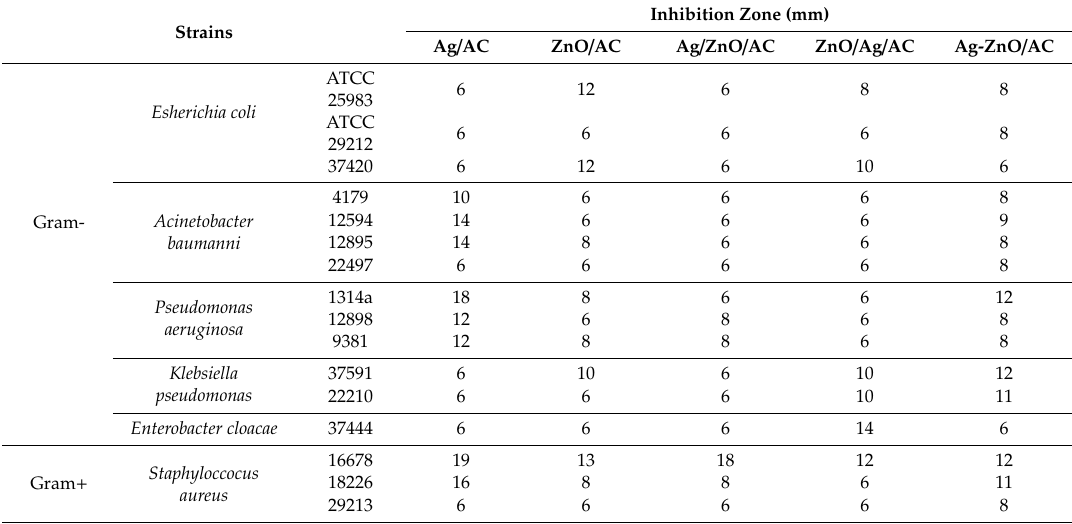
Table 1. Antimicrobial activity based on the inhibition zone diameter for gram-negative and